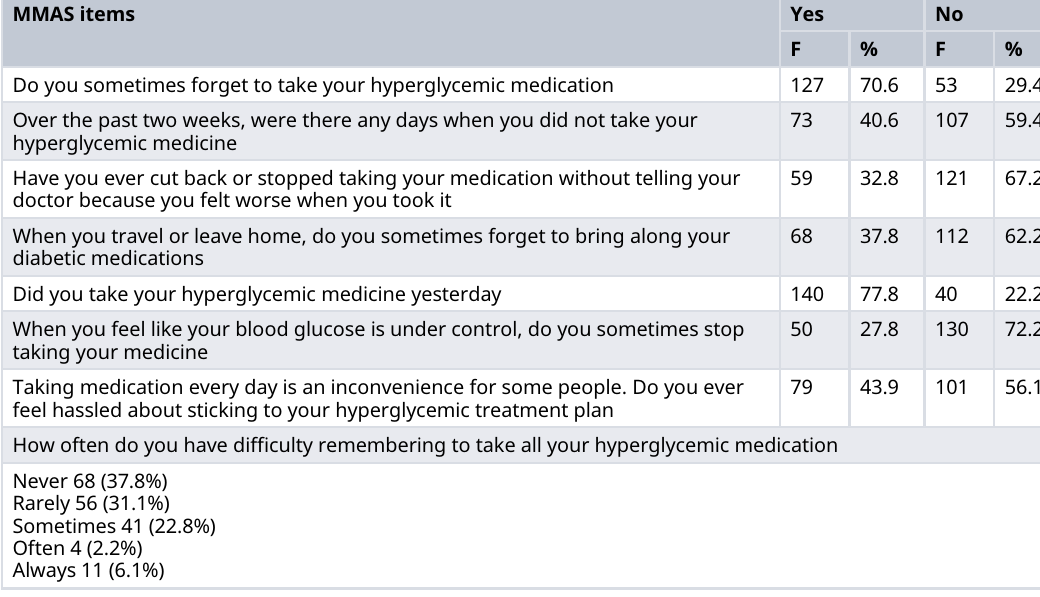
Table 3. Number and percentage of the questions on Morisky Medication Adherence Scale (MMAS). MMAS